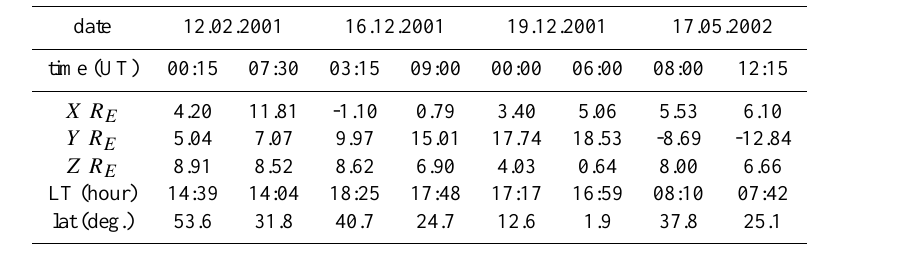
Table 1. Coordinates of the four time intervals on Cluster-1.